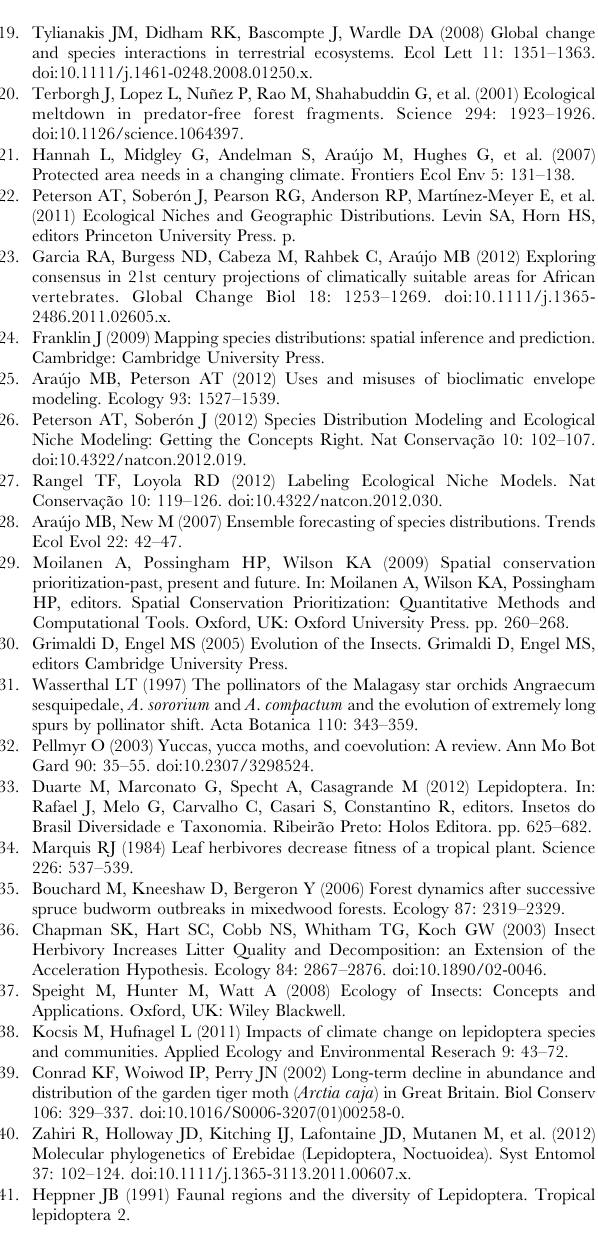
Table S1 Tiger moth tribes, species, True Skill Statistics (TSS) for each ecological niche modeling method and the ensembles among distance methods (Euclidian and Gower distance and ENFA) and machine-learning methods (MaxEnt, GARP, and Artificial Neural Networks). Table S2 Tiger moth tribes, species, and number of grid cells predicted to be occupied during baseline climate (1950–2000) and future climate (2051–2080) under different climate models and ecological niche modeling methods. Table S3 Tiger moth tribes, species, and percent of range contraction predicted to during baseline climate (1950–2000) and